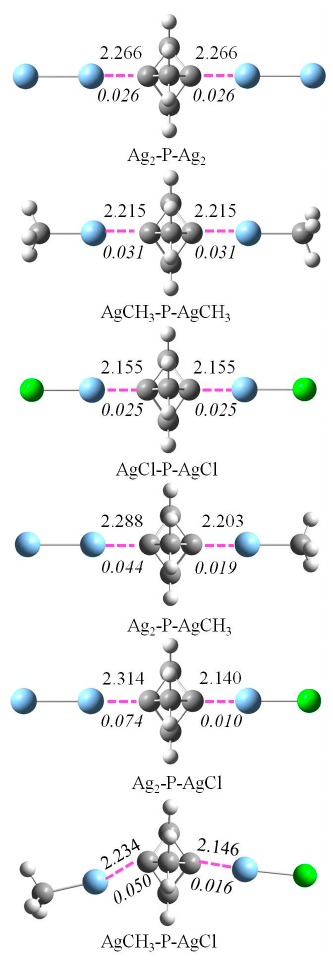
Figure 4. Optimized structures of ternary complexes with the binding distances (Å) and their difference (in italic) relative to the corresponding binary systems. Table 5. Total interaction energy ( ∆ E total ), the interaction energy between molecular pairs ( ∆ E), and cooperative energy (E coop ) in the ternary systems and all are in kcal /